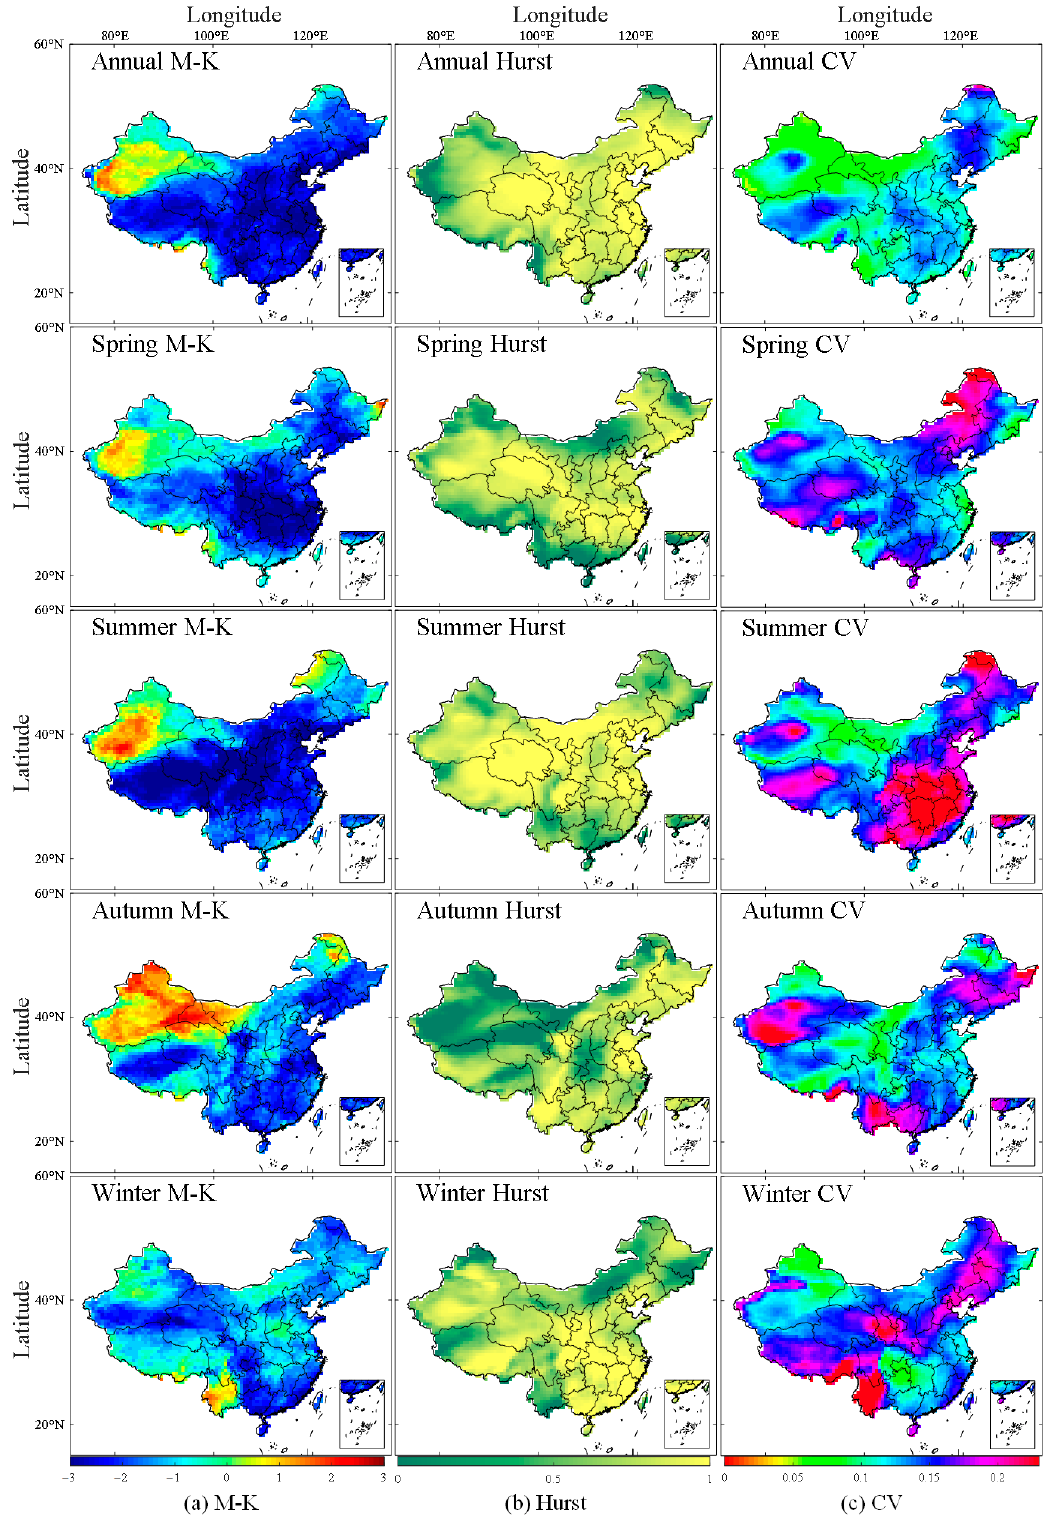
Figure 9. Results of the M–K test, Hurst index, and CV values computed from the annual and seasonal variations in AOD from 2010 to 2020.